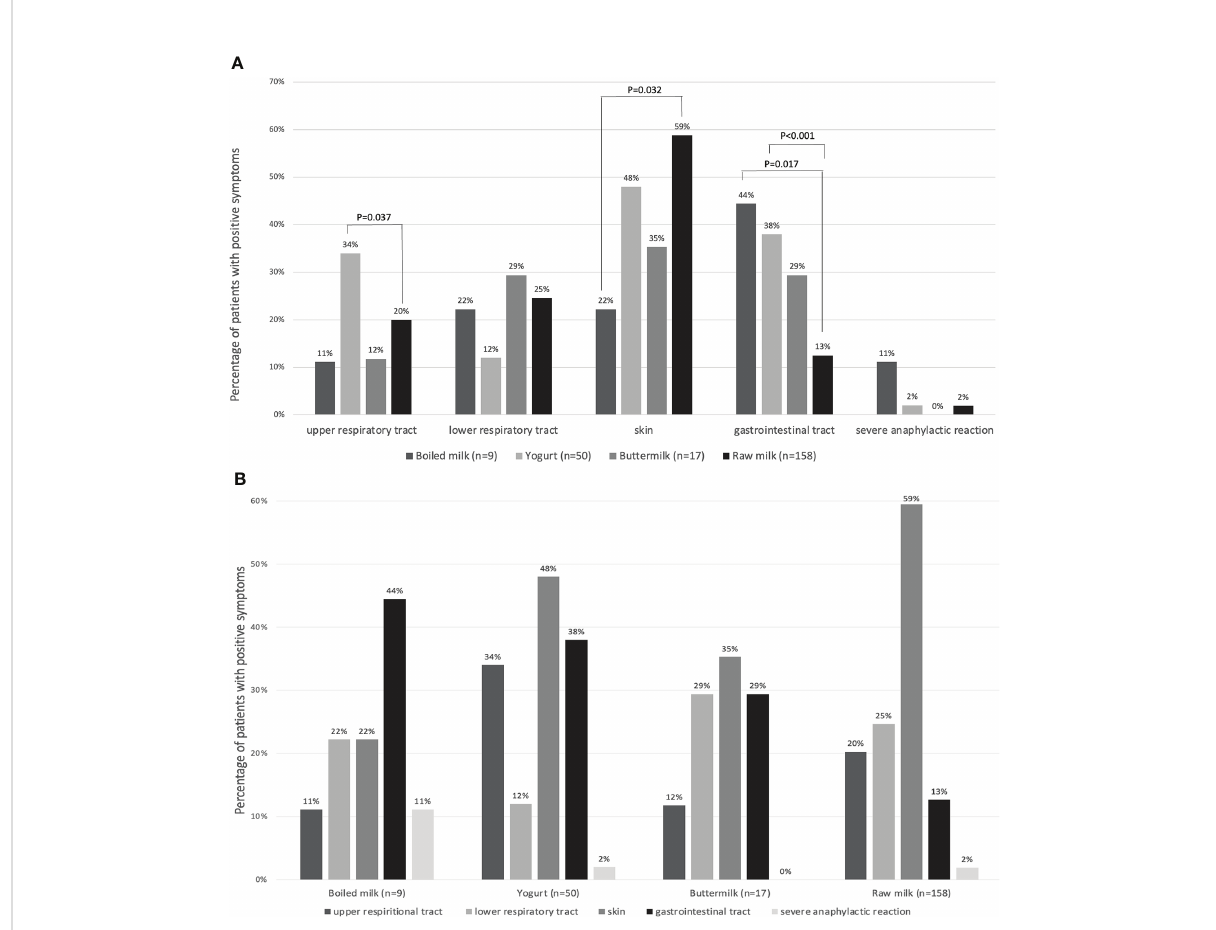
FIGURE 5 (A) The percentages of patients with allergic symptoms in four groups: boiled milk (n = 9), yogurt (n = 50), buttermilk (n = 17), and raw milk (n = 158), reported as groups by affected body systems. (B) The percentages of patients with allergic symptoms, reported as four